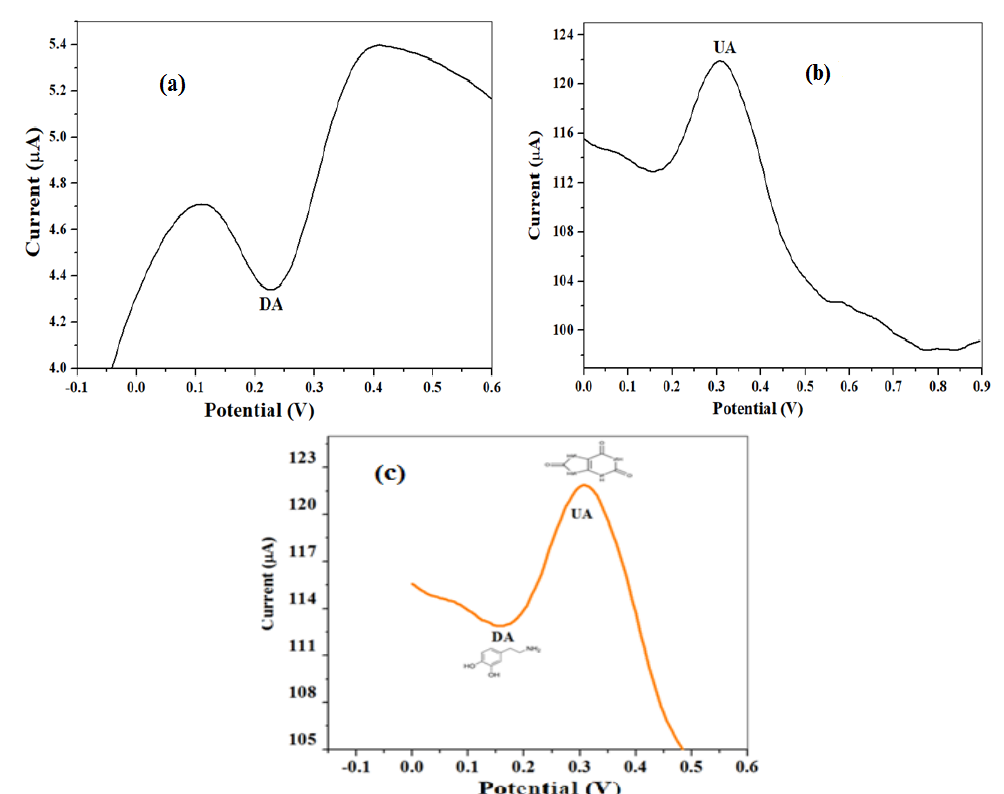
Figure 13. The SWV voltammogram for ( a ) 0.1 mM DA, ( b ) 0.1mM, and ( c ) mixture of DA and UA detected simultaneously